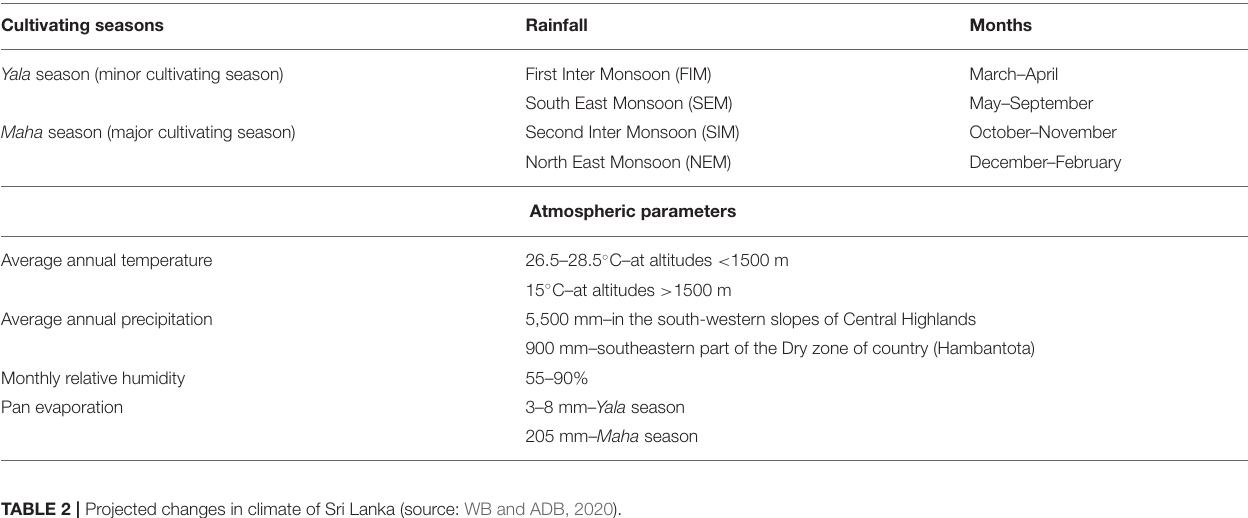
TABLE 2 | Projected changes in climate of Sri Lanka (source: WB and ADB, 2020).